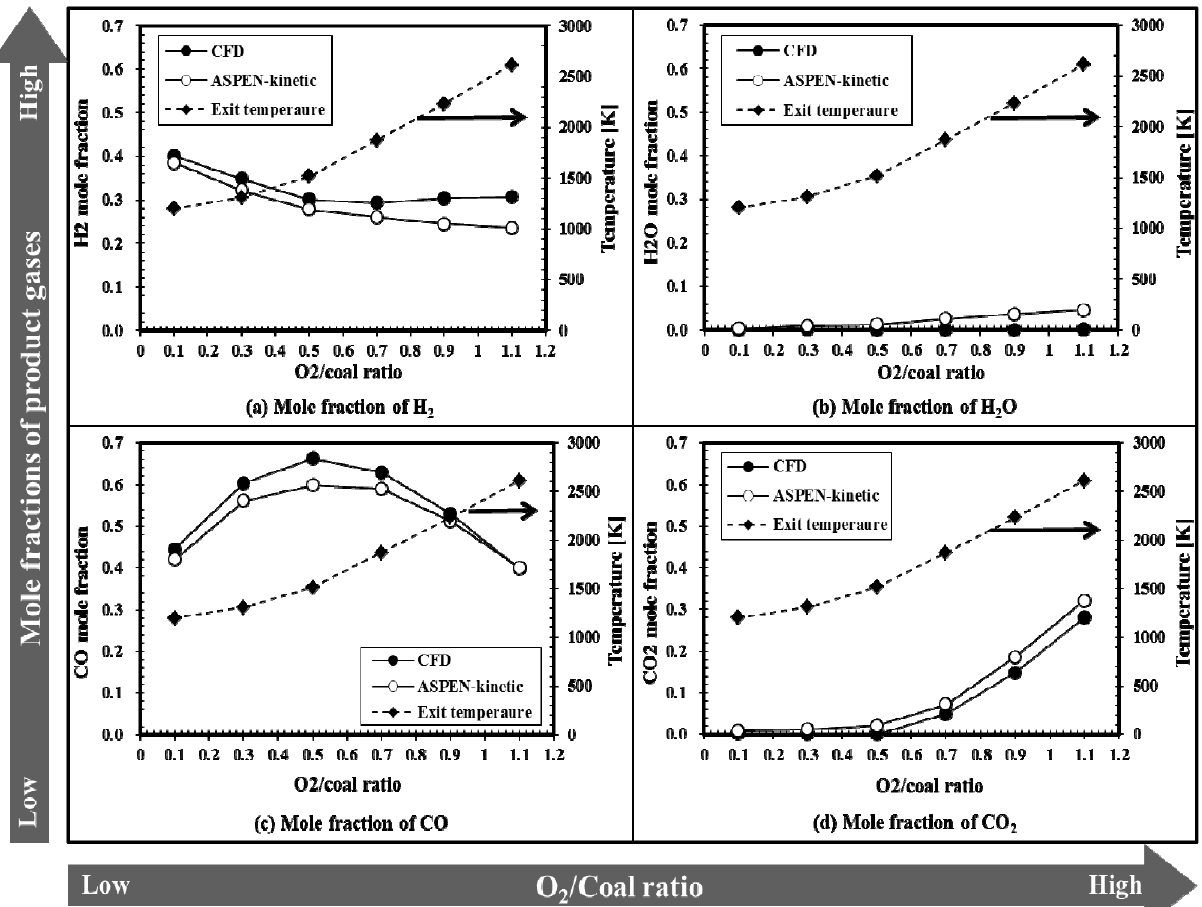
Figure 6. Comparison between CFD and ASPEN Plus